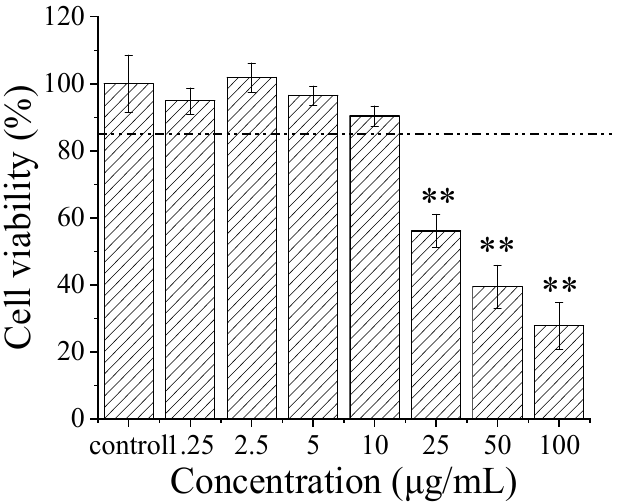
Figure 7. Cytotoxicity of GME on PC12 cells. Error bars are SD ( n = 6); ** p ≤ 0.01. Compared with control group.